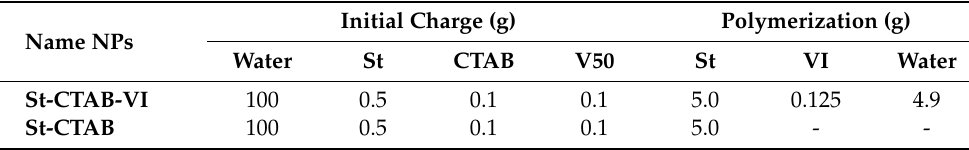
Table 1. Quantity of reagents used for the production of the NPs